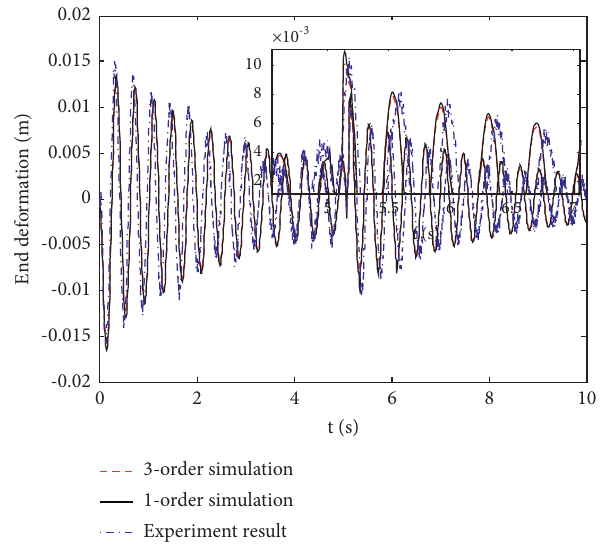
Figure 16: Comparison of deformation of flexible joint